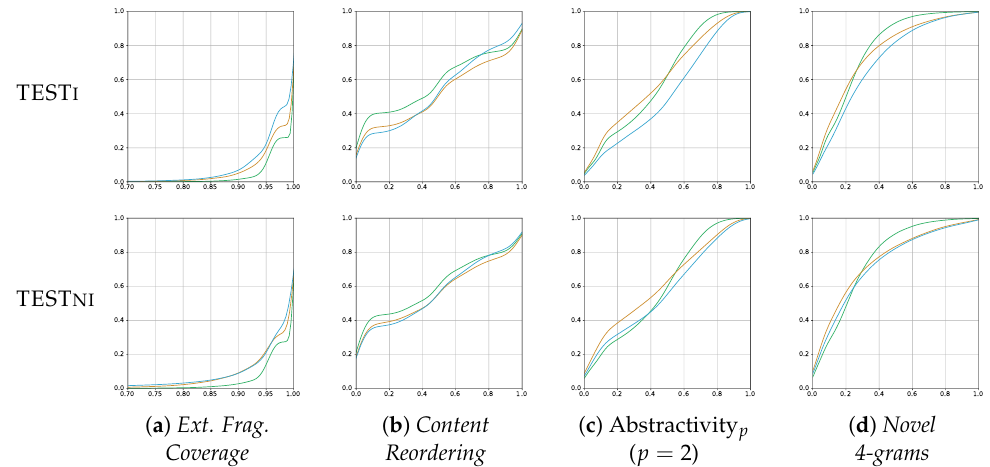
Figure 1. Cumulative distribution of 4 abstractivity indicators for models NAS CA , mBART, mT5 for